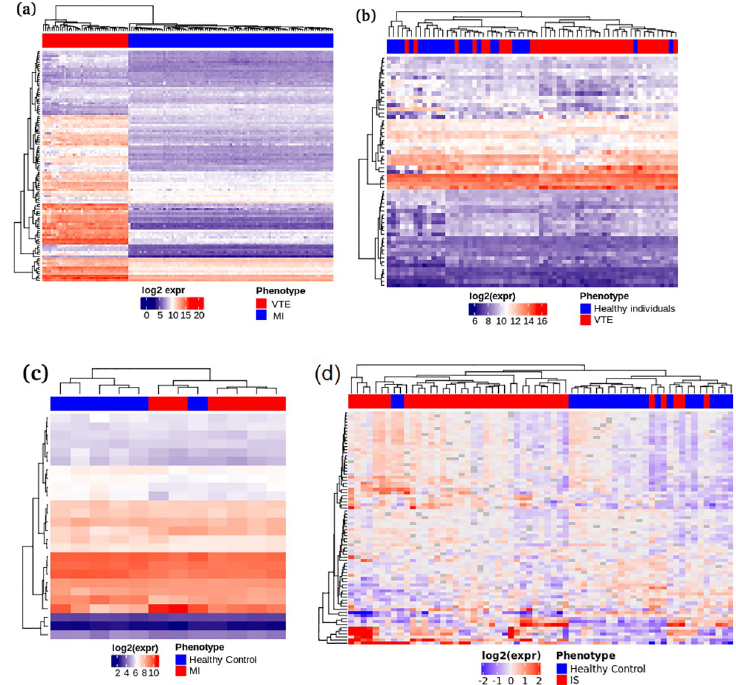
Fig 5. Clustering of VTE and CVD patients form independent (validation) cohorts, using gene lists (classifiers) identified by SVM-based methods derived from cohorts (training) used for the meta-analysis. In (a), a classifier consisting of 107 genes was capable to discriminate patients with at least two episodes of VTE (n = 71; red) from patients with AMI (n = 30; blue) with 100% accuracy. In (b), a classifier consisting of 60 genes was capable to discriminate the same population of VTE patients from healthy individuals with 76.5% accuracy. In (c), a classifier consisting of 23 genes was capable to discriminate the myocardial infarction patients from healthy individuals with 91.6% accuracy. Finally, (d) showed a classifier consisting of 76 genes capable to discriminate ischemic stroke patients from healthy individuals with 81.4% accuracy. log2(expr): base 2 logarithm of normalized expression; MI: myocardial infarction; VTE: venous thromboembolism; SVM: Support Vector Machine.